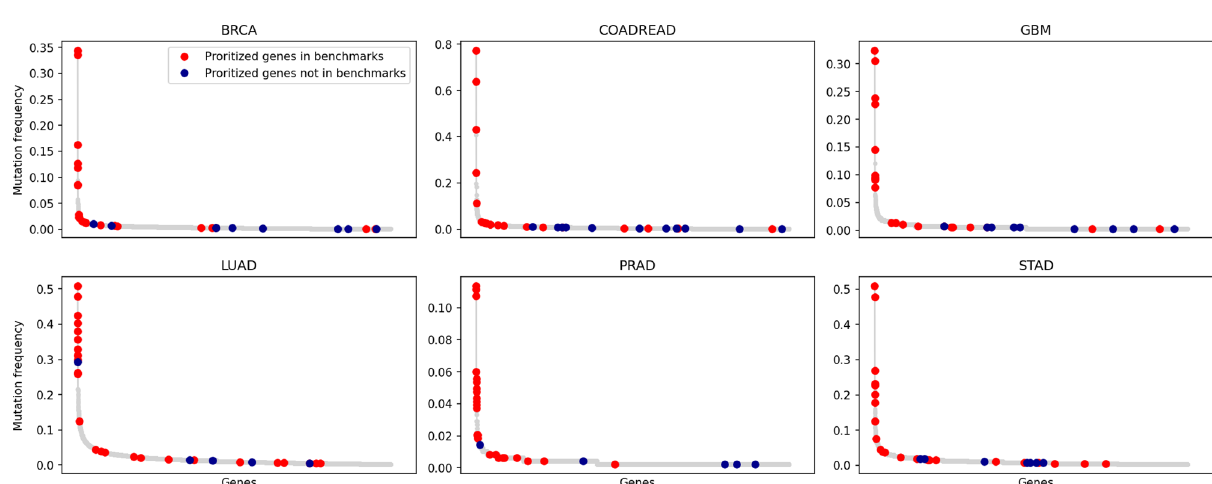
Figure 5. Low-frequency mutated